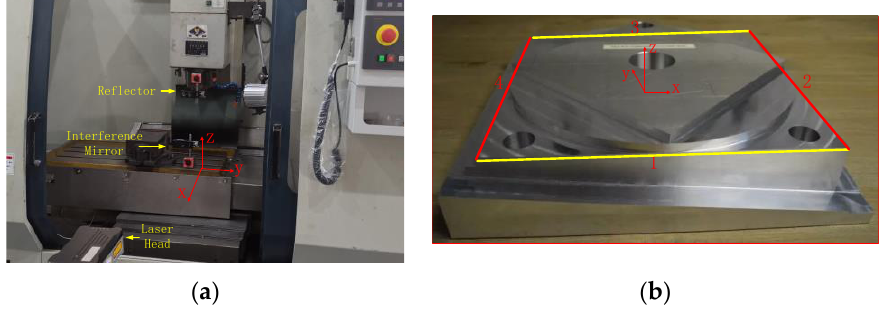
Figure 12. Experimental set-up and test piece: ( a ) experimental set-up; and ( b ) the test piece.